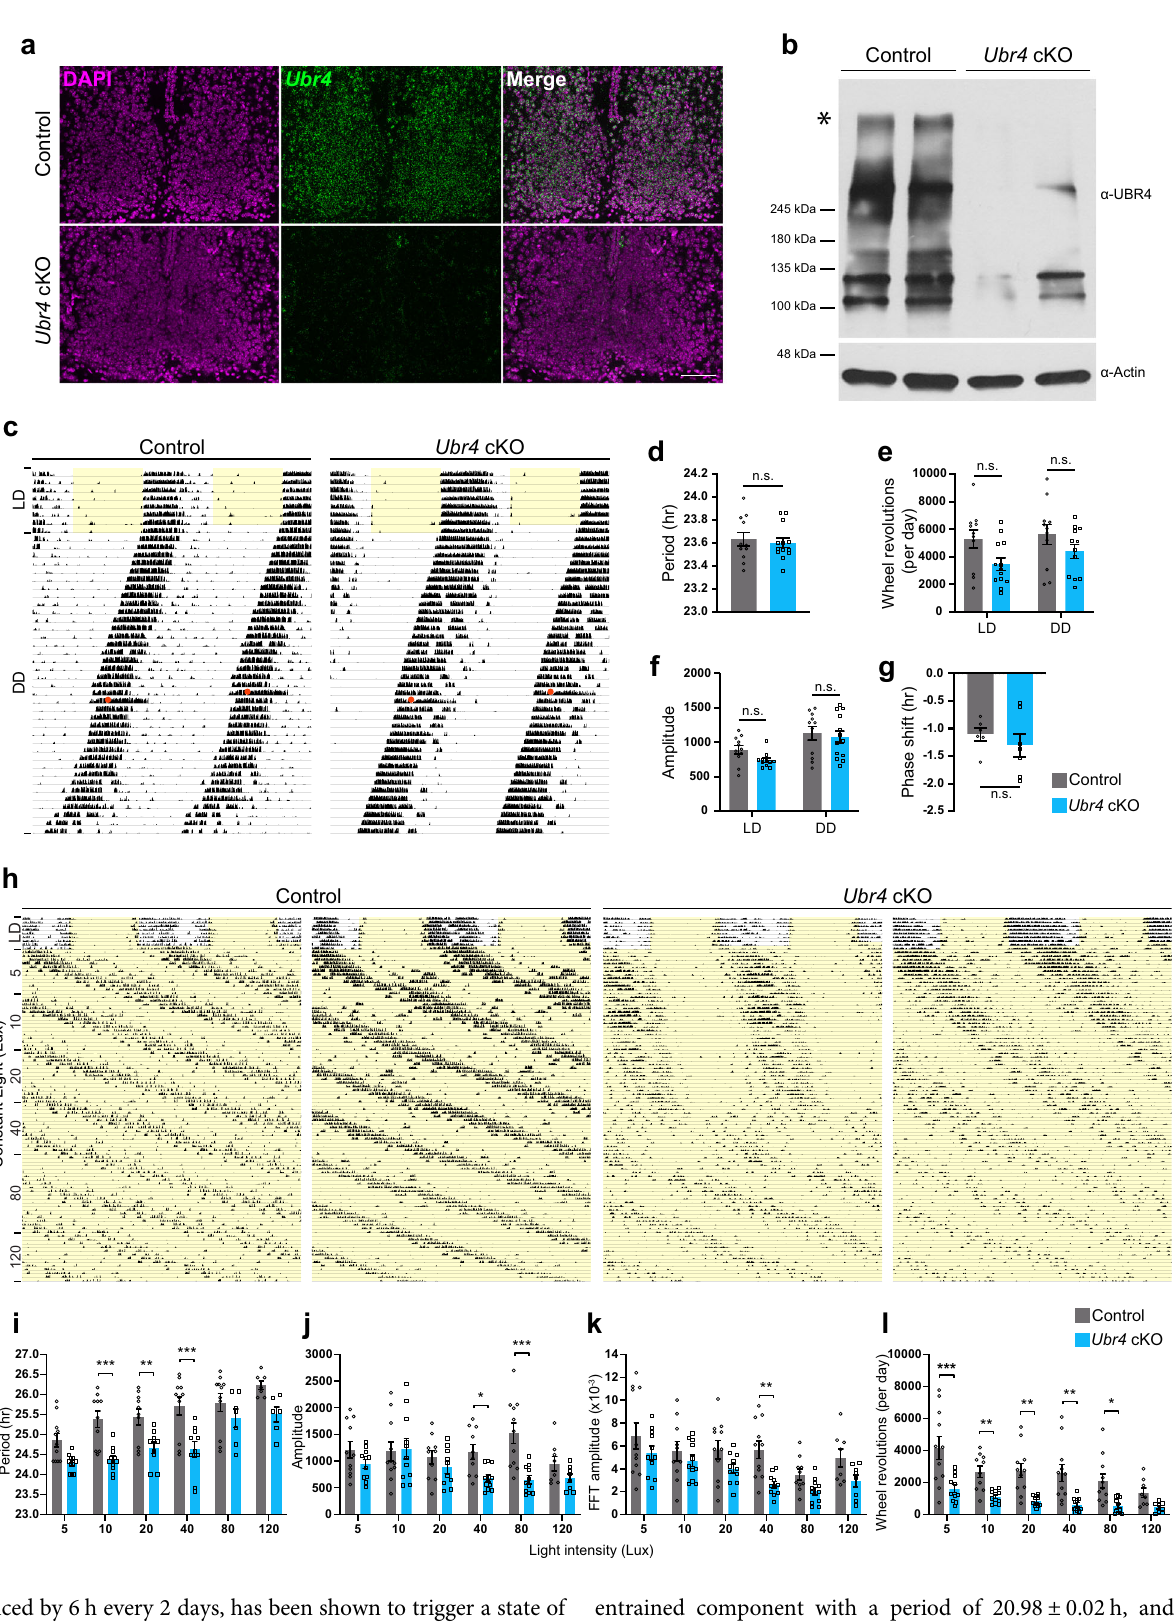
advanced by 6 h every 2 days, has been shown to trigger a state of internal desynchrony in a subset of C57Bl/6 mice, resulting in the emergence of two activity rhythms: a short-period component of ~21 h that signi fi es entrainment to the LD schedule and a long- period component of >24 h that is not entrained 26 . Under the ChrA 6/2 protocol, 44% (4/9) of control mice displayed a single,